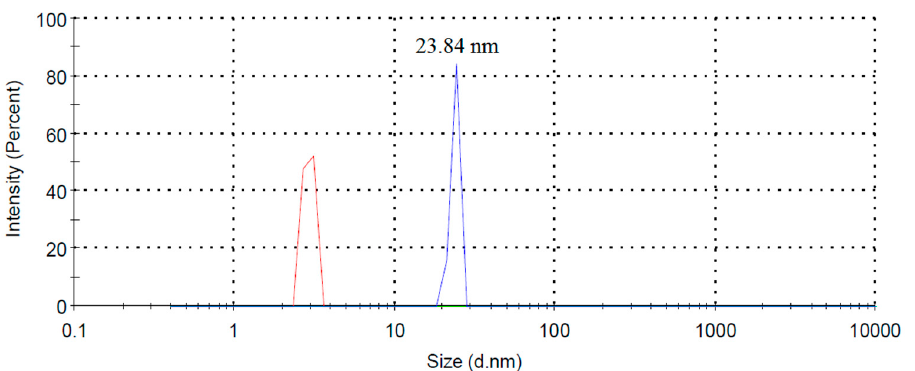
Figure 7. Size distribution of the synthesized CNPs.